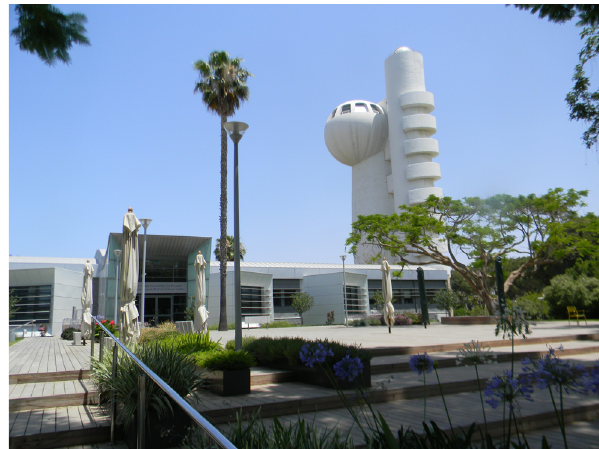
Figure 1: Building on the Weizmann Institute campus.